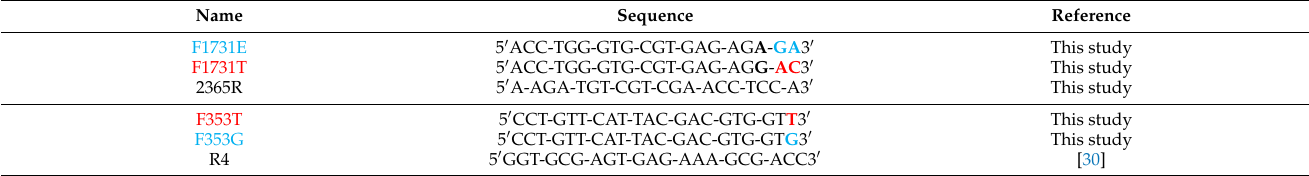
Table 2. PCR primers used to discriminate E/T/T’ pathotypes. Names of PCR primers and specific nucleotides are colored according Figure